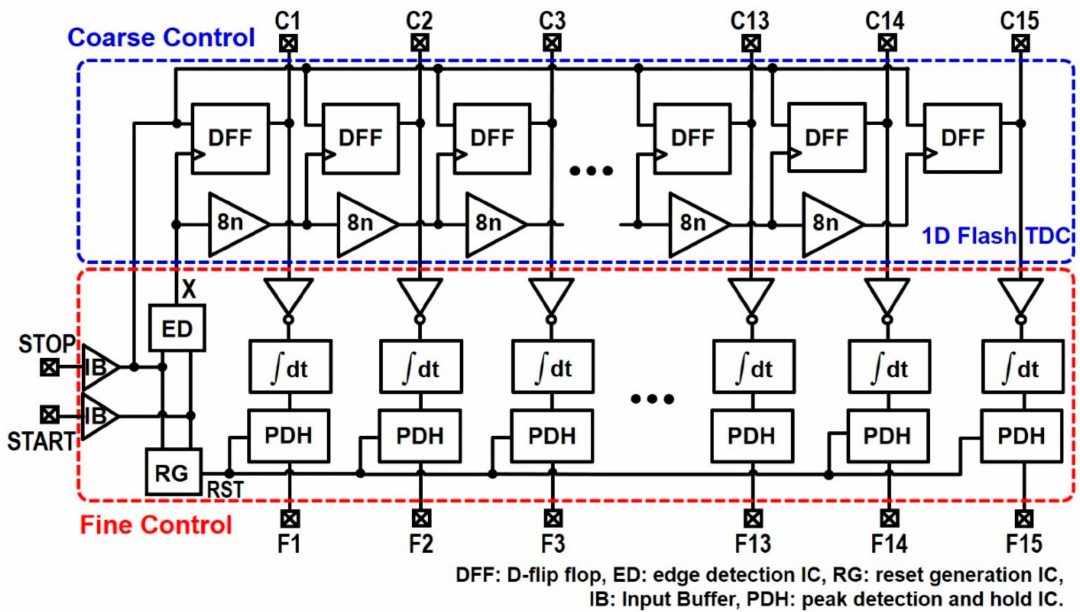
Figure 2. Block diagram of the proposed nine-bit